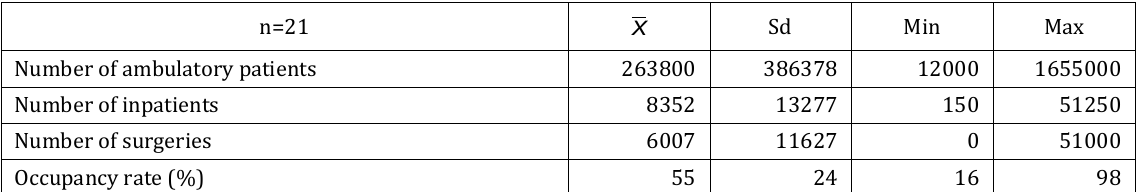
Table 2. Hospital service indicators for one year